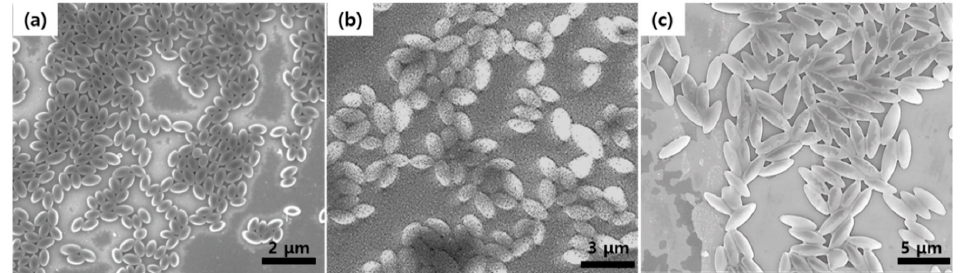
Figure 4. SEM images of the PS 34k - b -PB 25k particles’ MPA modification ( r = 0.5). Each particle was generated by membrane emulsification using different d pore , where pore sizes of ( a ) 0.5, ( b ) 1.1, and ( c ) 2.1 μ m were used, respectively.